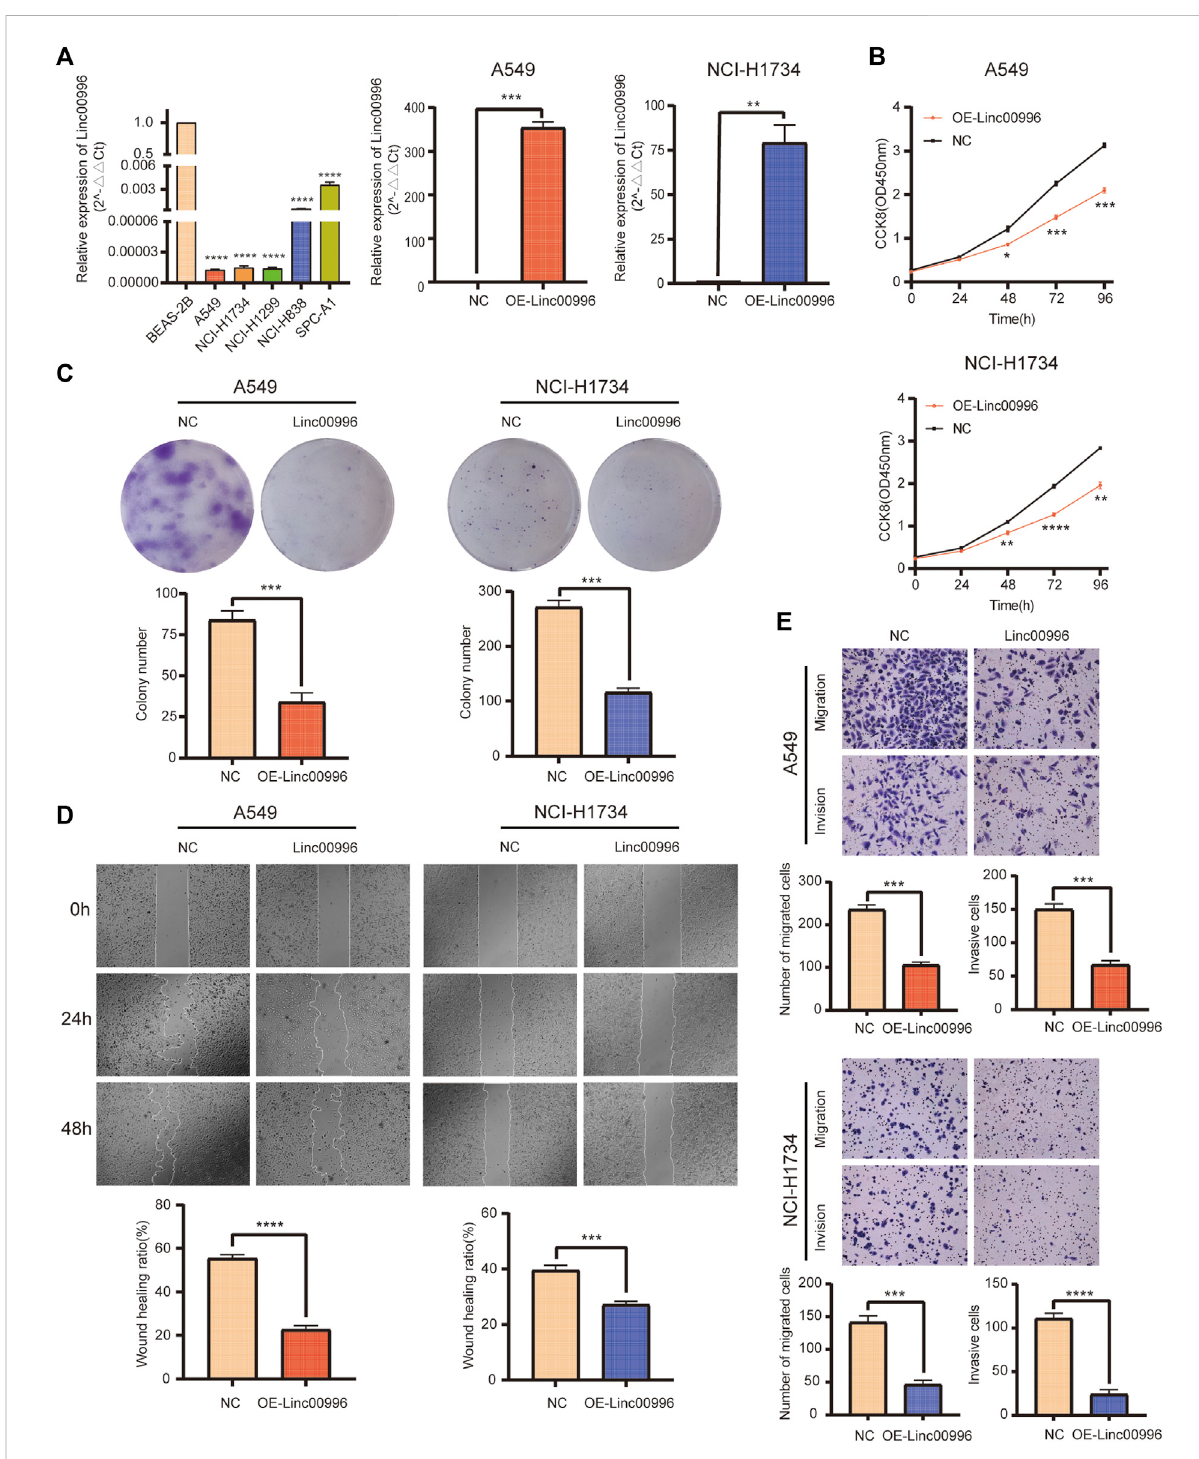
FIGURE 6 Linc00996 was critical for the cell growth, migration, and invasion of LUAD cells. (A) Linc00996 was underexpressed in LUAD cell lines (A549, NCI-H1734, NCI-H1299, NCI-H838, and SPC-A1). Overexpression of Linc00996 in A549 and NCI-H1734 cells was con fi rmed by RT-PCR. (B) Cell growth was inhibited by overexpression of Linc00996 in A549 and NCI-H1734 cells. (C) Overexpression of Linc00996 inhibited colony formation in A549 and NCI-H1734 cells. (D) Overexpression of Linc00996 inhibited cell migration, and wound healing assay was performed. (E) Overexpression of Linc00996 inhibited cell migration and invasion; representative images were shown. * p < 0.05, ** p < 0.01, *** p < 0.001, **** p <